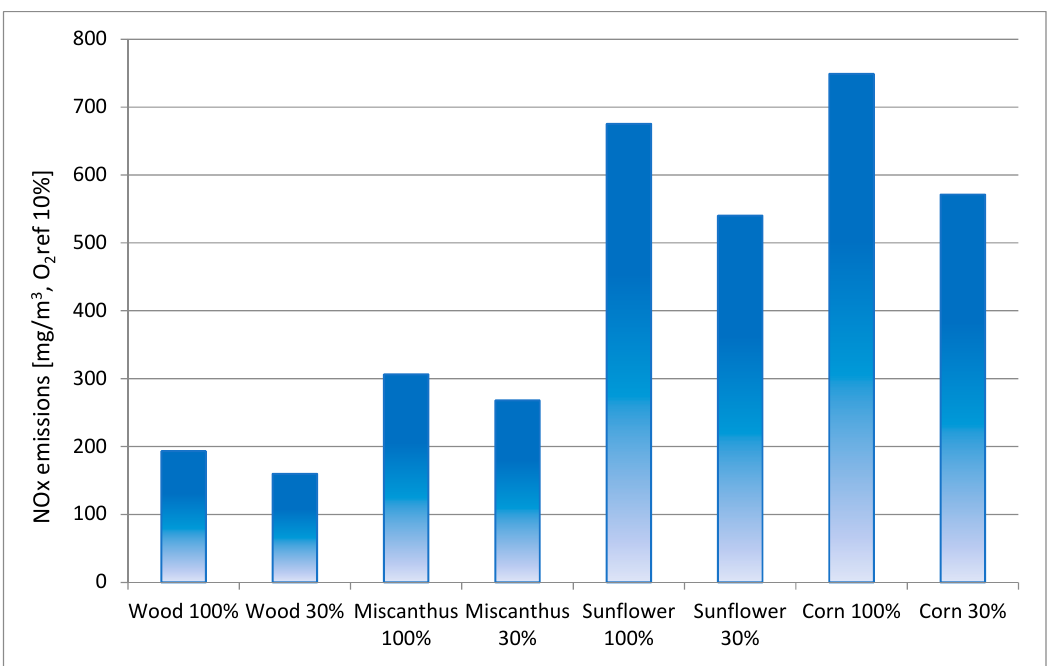
Figure 9. Comparison of CO emissions from different types of pellets.